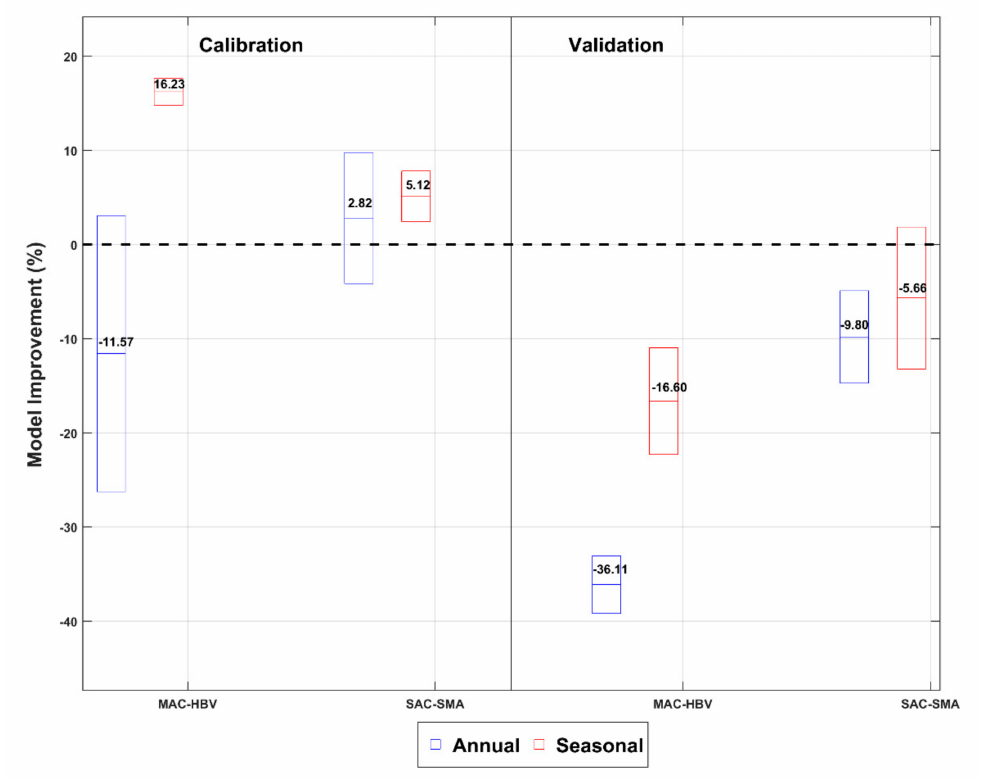
Figure 4. Model Improvement (defined by % reduction in RMSE) obtained by using the SNOW-17 model than DDM for UASR. The description is the same as in Figure 3, and as the model was calibrated at two stations, boxes here represent statistics for both the locations